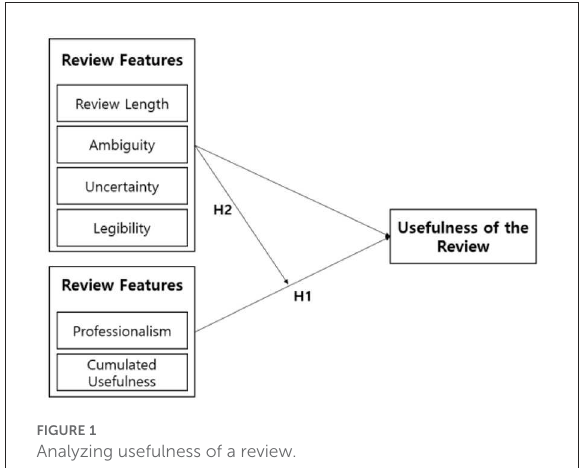
FIGURE1 Analyzing usefulness of a